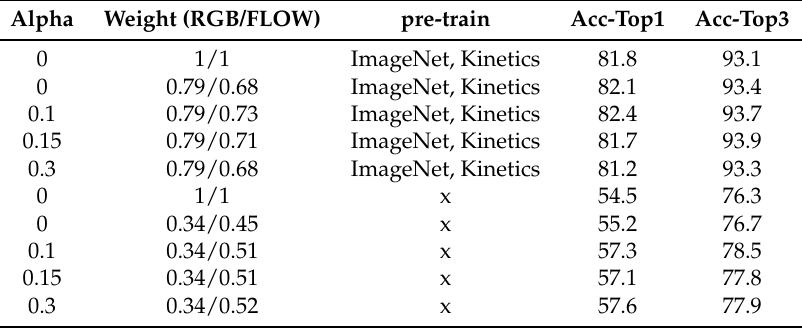
Table 4. Experiment about Score Fusion on HMDB-51.